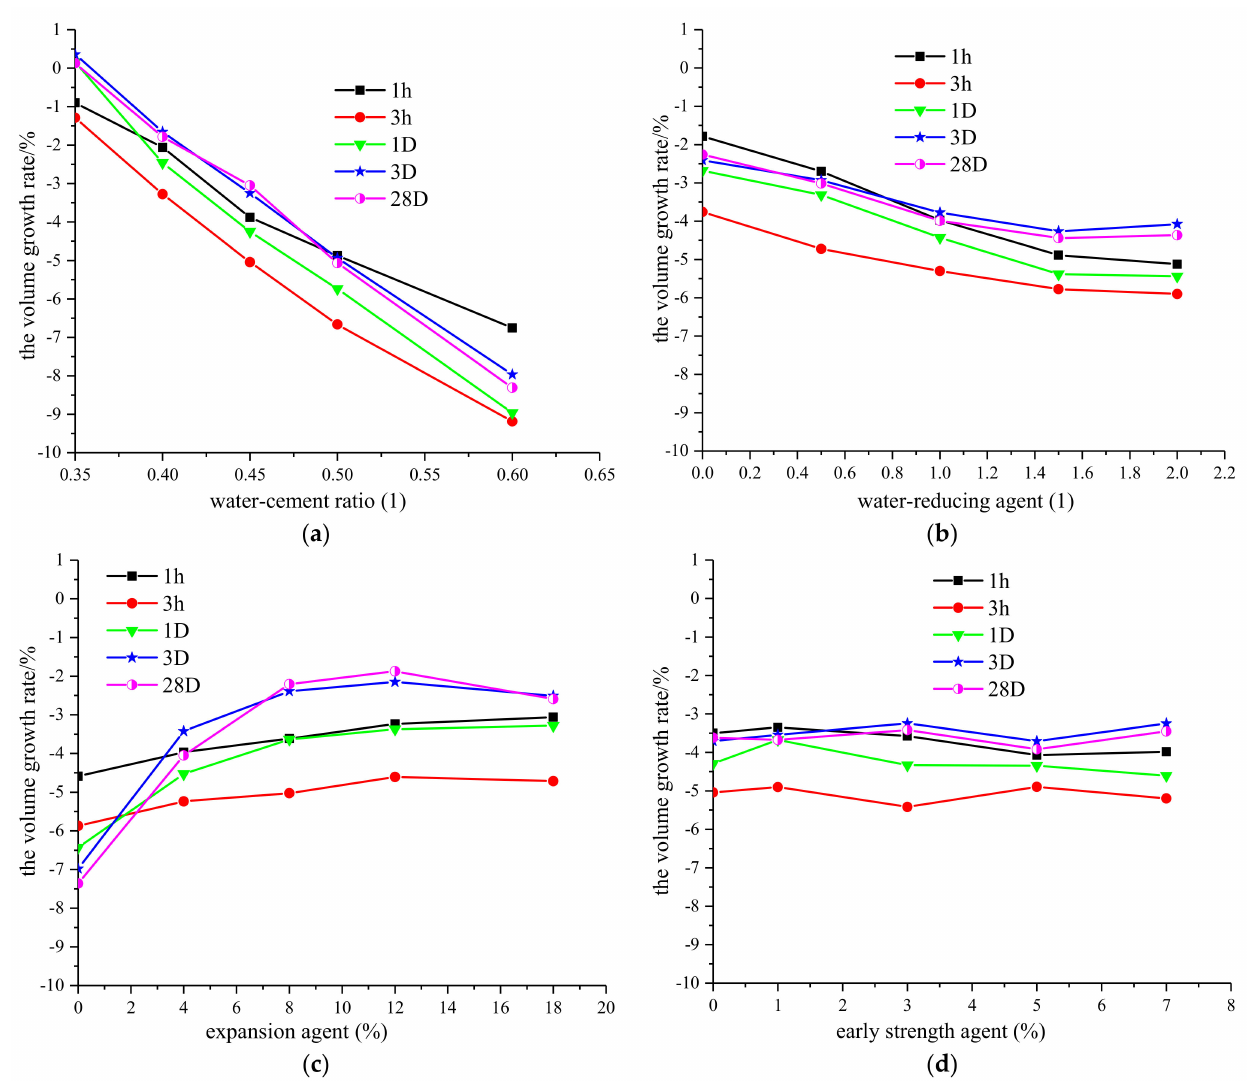
Figure 5. The influence of various factors on the volume growth rate of the grouting body correspond- ing to the curing time of 1 h, 3 h, 1 day, 3 days and 28 days, respectively. ( a ) Influence of water–cement ratio on the volume growth rate; ( b ) influence of water-reducing agent on the volume growth rate; ( c ) influence of expansion agent on the volume growth rate; ( d ) influence of early-strength agent on the volume growth